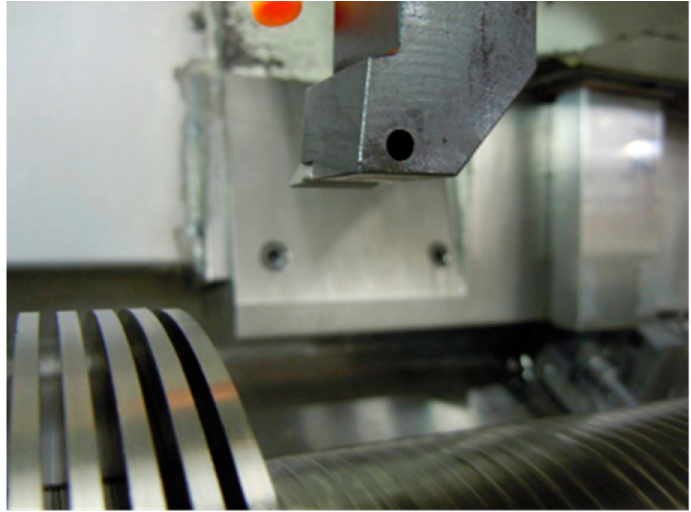
Figure 3. Test set-up for orthogonal turning tests using a flanged Ti6Al4V work piece.